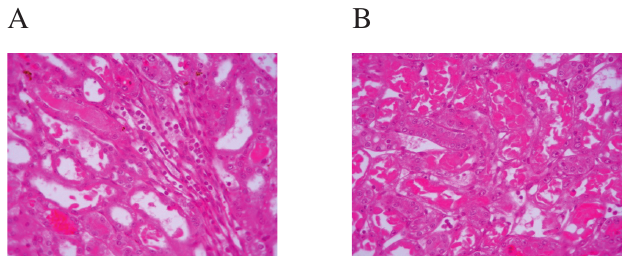
TABLE 2 - Scores of tubular dilation (TD) and tubular degeneration (TDe) in the right ® .01and left (L) kidney according to group.